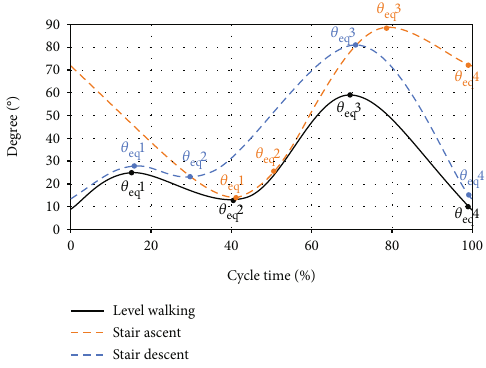
Figure 10: Measuring result of the knee